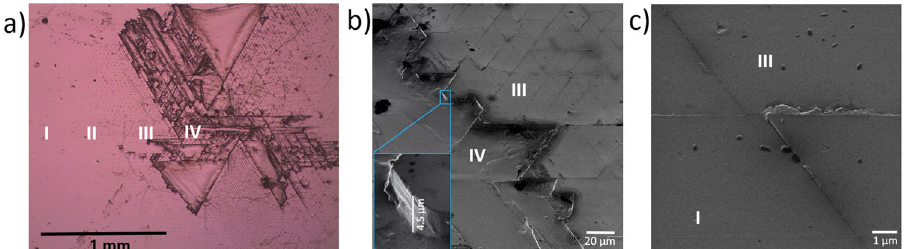
Fig. 2 Microscope images of silicon samples after exposure to a laser-ion pulse. Optical, ( a ), and helium ion microscope (HIM) images, ( b ) and ( c ), of a silicon (111) sample that had been exposed to one laser ion pulse. a) The optical image shows areas with no surface damage (I) adjacent to areas with tessellation patterns (II), (III) and exfoliation (IV). The insert in b) shows the thickness of an exfoliated layer of 4.5 μ m. c Shows an area where a silicon tile started to peel off in response to the local ion fl ux (III). At the top of the exfoliating tile, re-solidi fi ed silicon that melted appears to have emerged from under the tile. Note that the HIM images show the key features of the regions labeled (III), (IV) but are not of the exact same regions marked in the optical image. Region (I) in a ) and ( c ) is representative of the unexposed silicon, which showed no features in HIM or optical microscopy. images (the latter obtained under an angle of 45 degrees) of a silicon (111) sample that had been exposed to one ion pulse. The optical image was taken at a magni fi cation of 6.25x in order to provide an overview of the highly non-uniform surface topo- graphy across an area of about 6 mm 2 . In the center of the image (IV), we observe a region where layers of silicon were exfoliated. These exfoliated sections are separated by a sharp transition from neighboring areas showing triangular tessellation patterns of cracks that re fl ect the silicon (111) crystal structure (III).